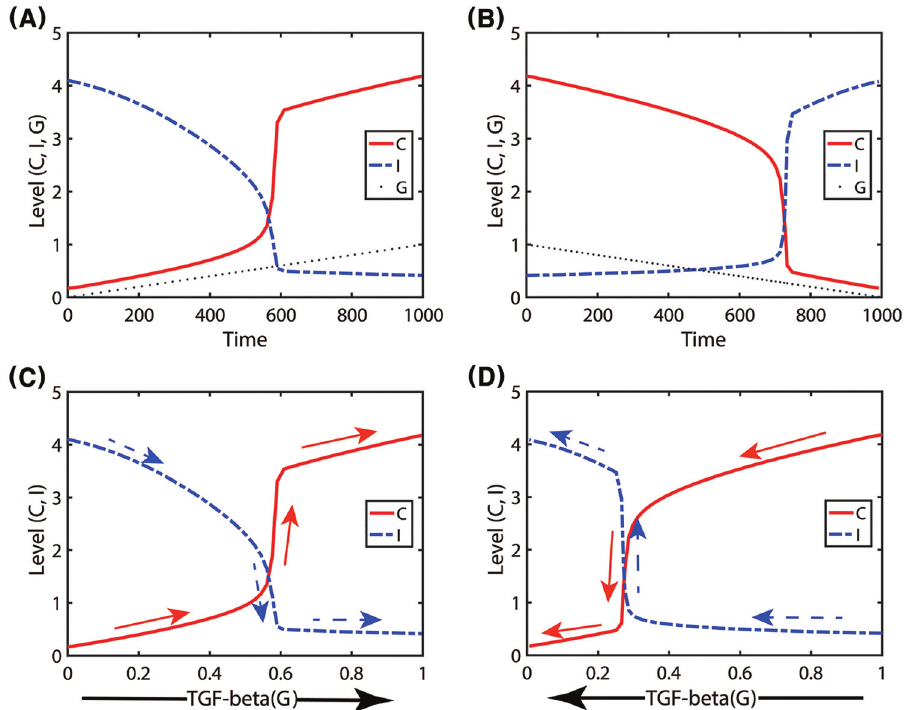
Fig 7. Immune response of TANs to increasing or decreasing TGF- β . (A, B) Time courses of the N2 ( C , red solid curve) and N1 ( I , blue dashed curve) levels as the TGF- β level ( G ; black dotted line) is slowly increased (from 0 to 1.0 in (A)) and slowly decreased (from 1.0 to 0.1 in (B)), respectively. (C, D) Change of C and I as a function of G corresponding to (A, B), respectively. Arrows indicate the moving direction of the solutions. S = 0.2. Other parameters are given in Table 2. including the bistability region W (Fig 6). The corresponding trajectory of the solutions ( C , I ) G along G is shown in Fig 7D. In Fig 8, we test the effect of fluctuating TGF- β on tumor growth. A time-dependent TGF- β level was assigned for a periodic supply of TGF- β in tumor microenvironment as follows (Fig 8A):